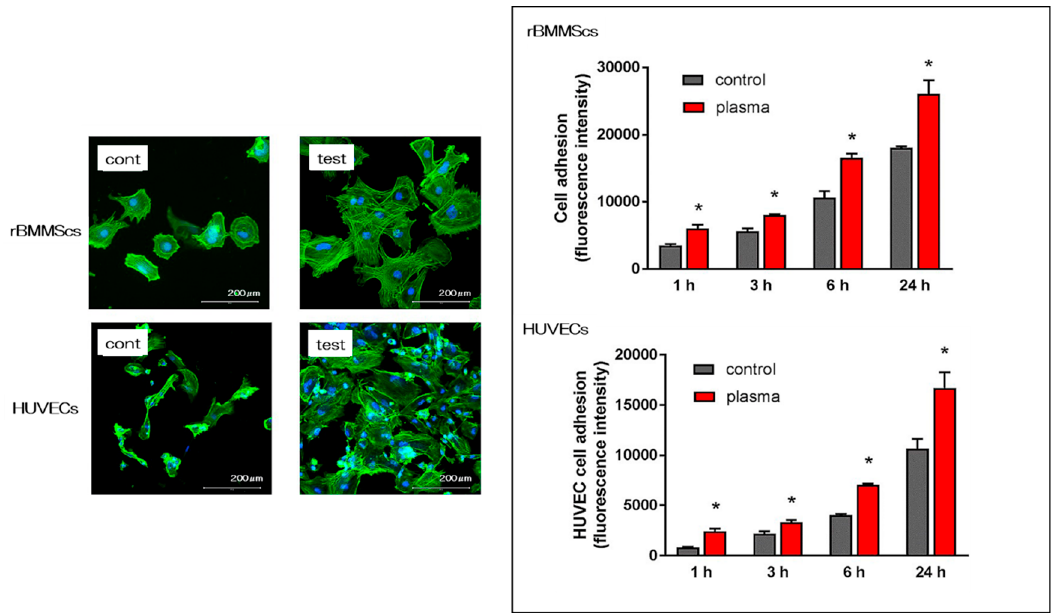
Figure 3. As a result of observation after 24 h of culture with a fluorescence microscope, images showing cell adhesion of rBMMSCs and HUVECs were observed on the material surface in both groups. By alkali and plasma treatments, elongation of cell processes of both cells was observed. In addition, when the number of initial rBMMSCs adhesion and HUVECs was compared at each culture time, it was found that the number of cell adhesion increased with the passage of culture time. Furthermore, the material surface of the test group showed a statistically significantly higher value than that of the control group at all measurement times. * p <